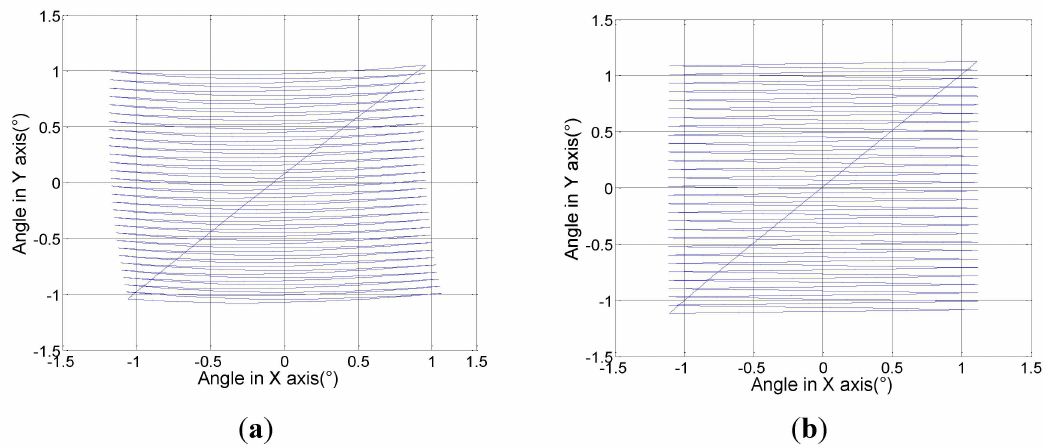
Figure 11. The comparison of controlled and non-controlled raster scan patterns. ( a ) Scan pattern with standard triangular voltage signals; ( b ) Scan pattern with the model-generated signals as in Figure 9.